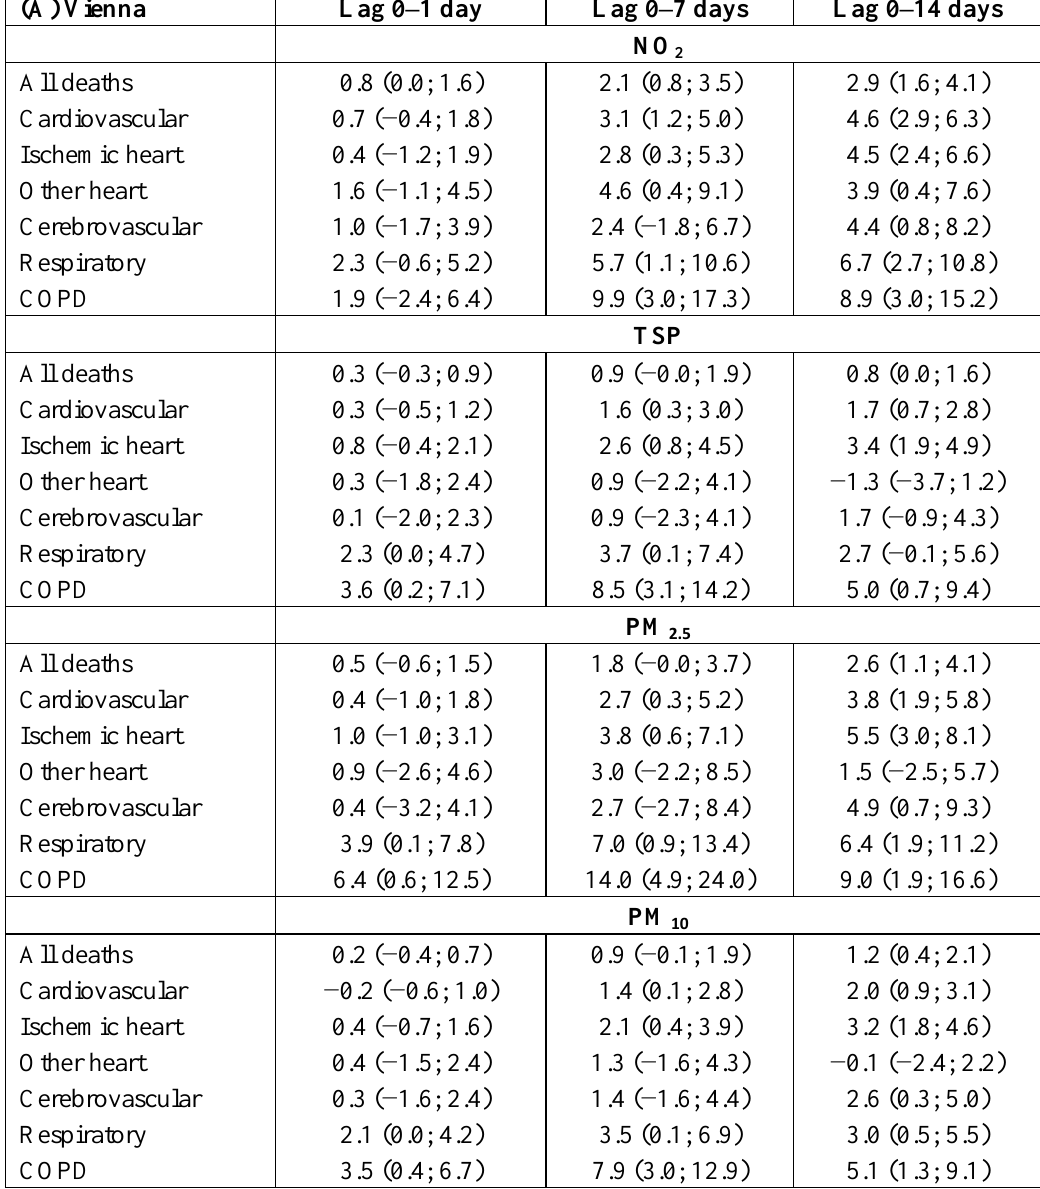
Table S1. Lag-structure and degrees of freedom in the models. ( A ) Per cent increase in mortality (with 95% confidence intervals) related to a 10 µg/m³ increase in pollution—Vienna. ( B ) Per cent increase in mortality (with 95% confidence intervals) related to a 10 µg/m³ increase in pollution—Graz. ( C ) Per cent increase in mortality (with 95% confidence intervals) related to a 10 µg/m³ increase in pollution—Linz